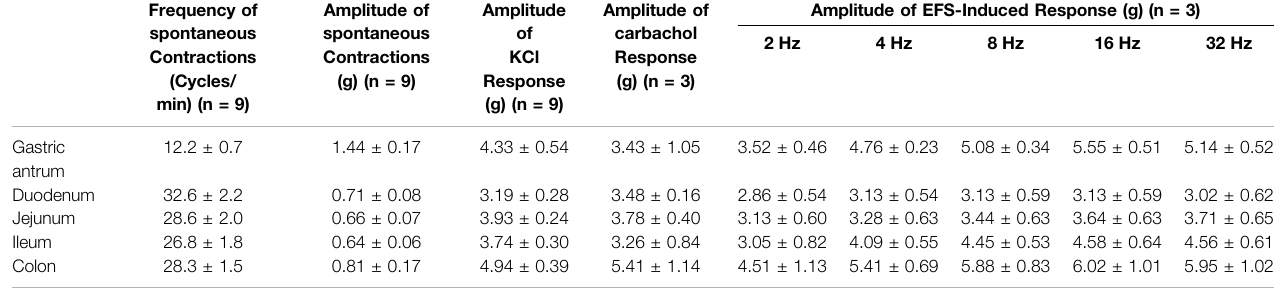
TABLE 2 | Summary of the contraction frequency and amplitude of the gastrointestinal tract tissues in vitro .